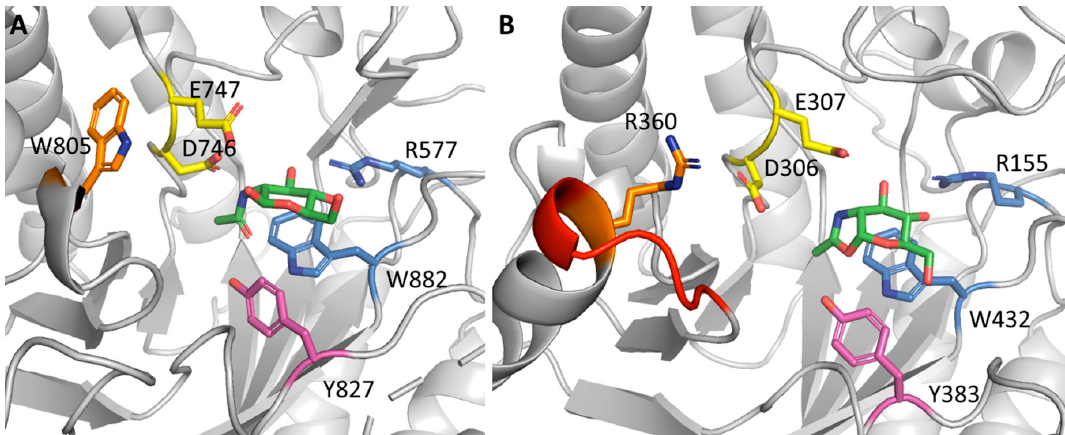
Figure 7. Active sites models of two bacterial β - N -acetylhexosaminidases: ( A ) homology model of BbhI from Bifidobacterium bifidum (created with YASARA [138]) with the mutated W805 [104] highlighted in orange and GlcNAc bound in the active site; ( B ) homology model of Hex1GTEPG [117] with the inserted loop highlighted in red and the newly positioned R360 in orange; the reaction intermediate Glc-oxa was docked into the structure [117]. The catalytic Asp-Glu pair is highlighted in yellow, the water-stabilizing Tyr residue is highlighted in purple, bound or docked ligands are highlighted in green, and conserved residues (Arg and Trp) are highlighted in dark blue.